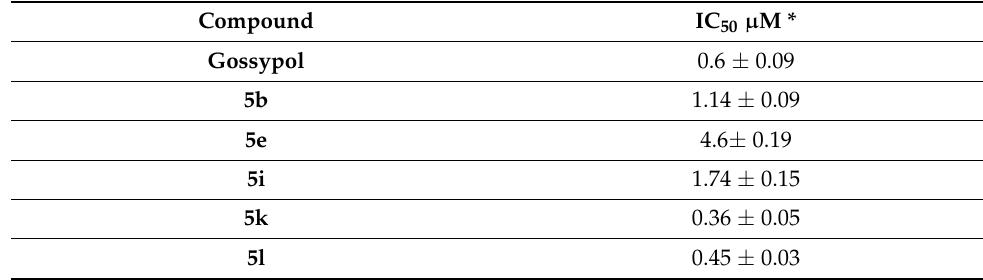
Table 2. The IC 50 of the selected compounds in ELISA as binding assay for Bcl-2.